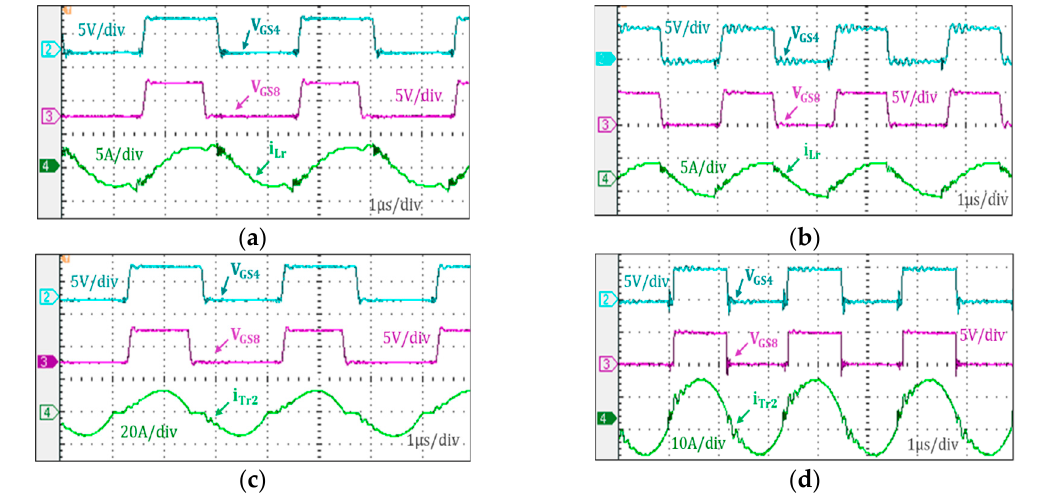
Figure 10. Main experimental waveforms of the forward mode. ( a ) Waveform of i Lr when f s = 312 kHz; ( b ) waveform of i Lr when f s = 435 kHz; ( c ) waveform of i Tr2 when f s = 312 kHz; ( d ) waveform of i Tr2 when f s = 435 kHz. Energies 2019 , 12 , x FOR PEER REVIEW